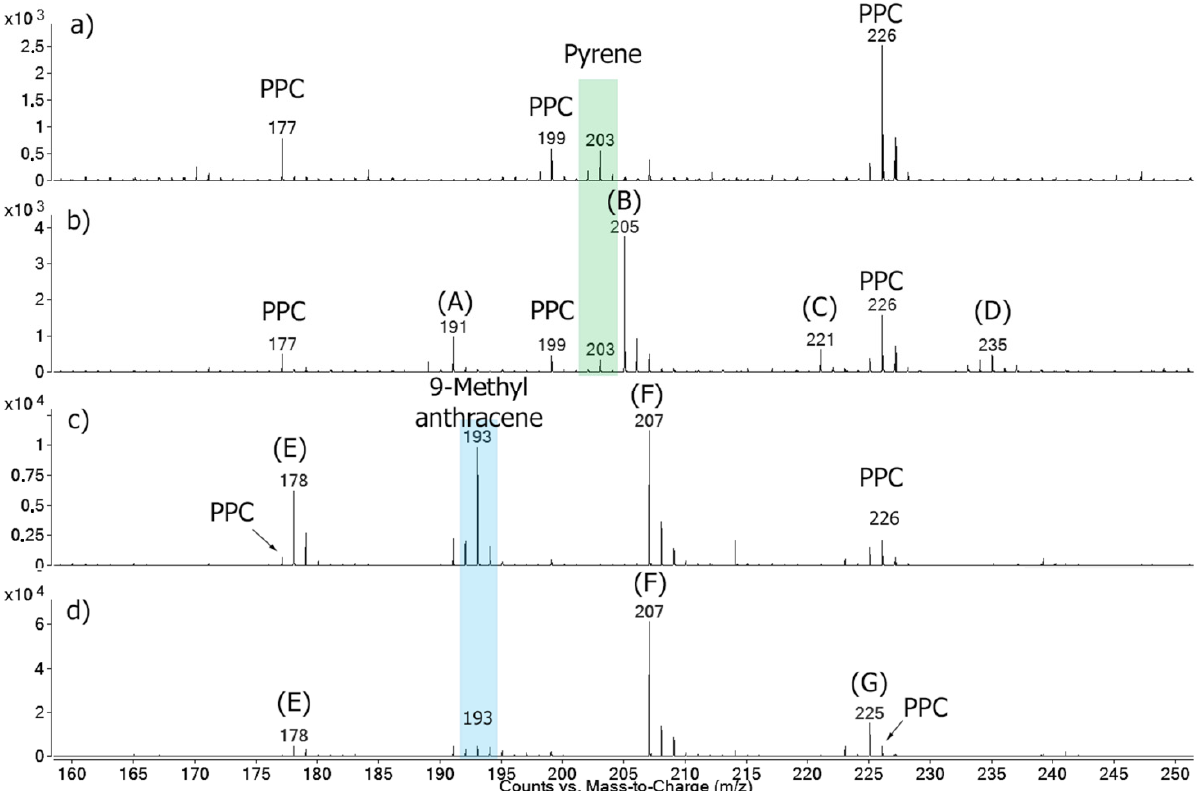
Figure 5. MS spectra of the ( a ) untreated and ( b ) treated PPC impregnated with pyrene; ( c ) untreated and ( d ) treated PPC impregnated with 9-methylanthracene; all after the heterogeneous experiments performed under dry conditions. In figure: (A) Unidentified phenanthrenic structure; (B) cyclopenta[def]phenanthren-4-one [43]; (C) 4-oxapyren-5-one [39–42]; (D) phenanthrene-4,5-dicarboxaldehyde [39–42]; (E) anthracene; (F) 9-anthracenecarboxaldehyde; and (G) hydroxy-9,10-anthracenedione [45]. (The green and blue rectangles indicate the pyrene and 9-methylanthracene signals, respectively). The scale is normalized to the base peak.